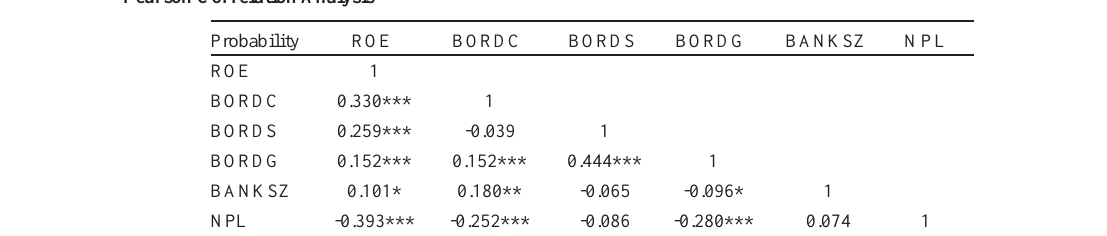
Table 2. Pearson Correlation Analysis